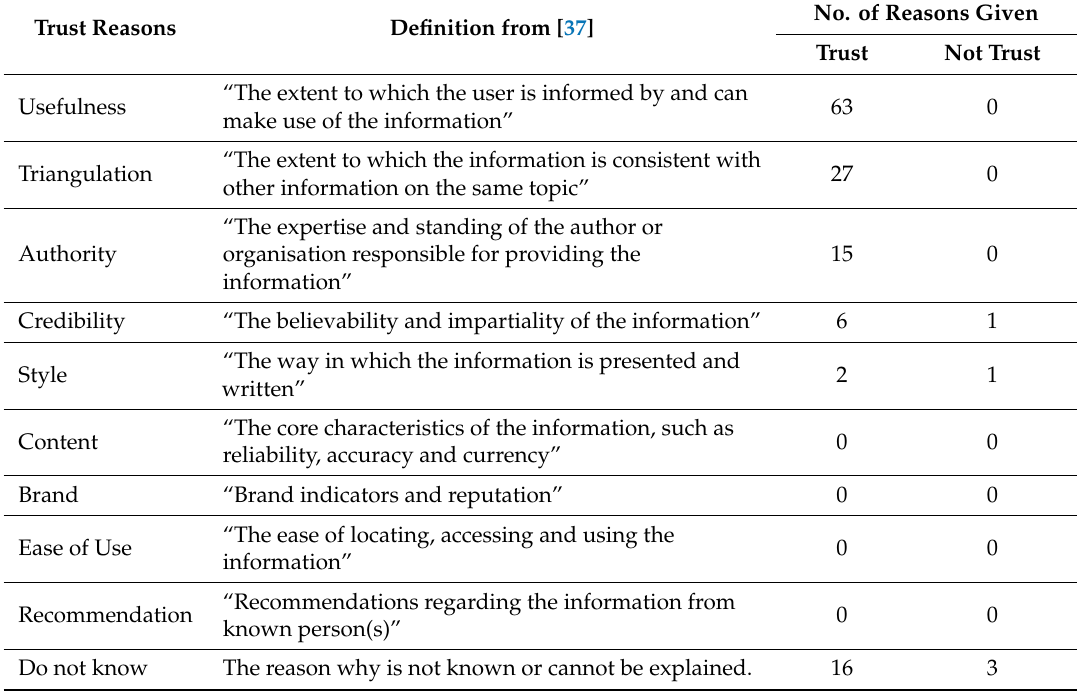
Table 8. Children’s reasons for trusting / not trusting the results mapped onto di ff erent constructs of trusts identified by Johnson, Sba ffi and Rowley [37] in the research